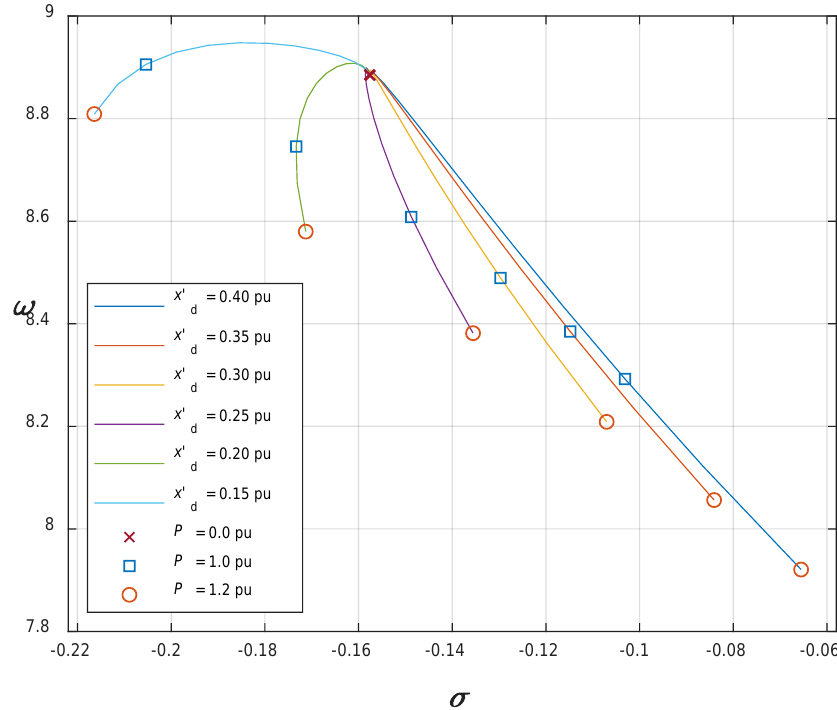
Figure 19. Eigenvalue loci of local mode of a 158-MVA hydro-type synchronous generator with AVR system at reactive power Q = 0.6 pu, and active power values from P = 0.0 pu to P = 1.2 pu for different values of the direct-axis transient reactance x d ’.